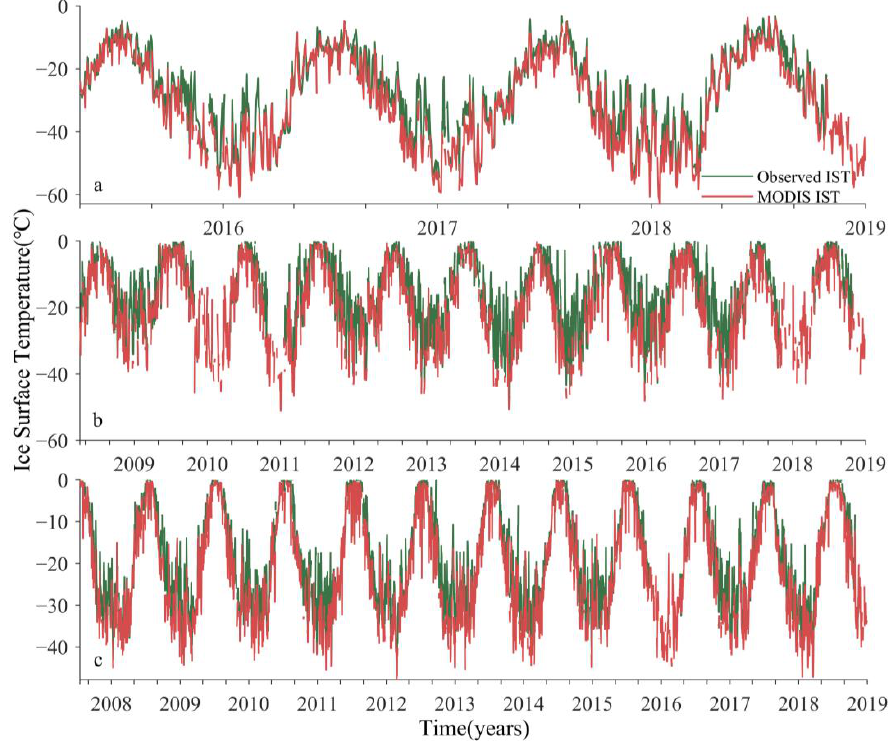
Figure 4. Time series of MODIS IST (red line) and surface temperature (green line) from EGP ( a ), KAN_U ( b ), and KPC_U ( c ).